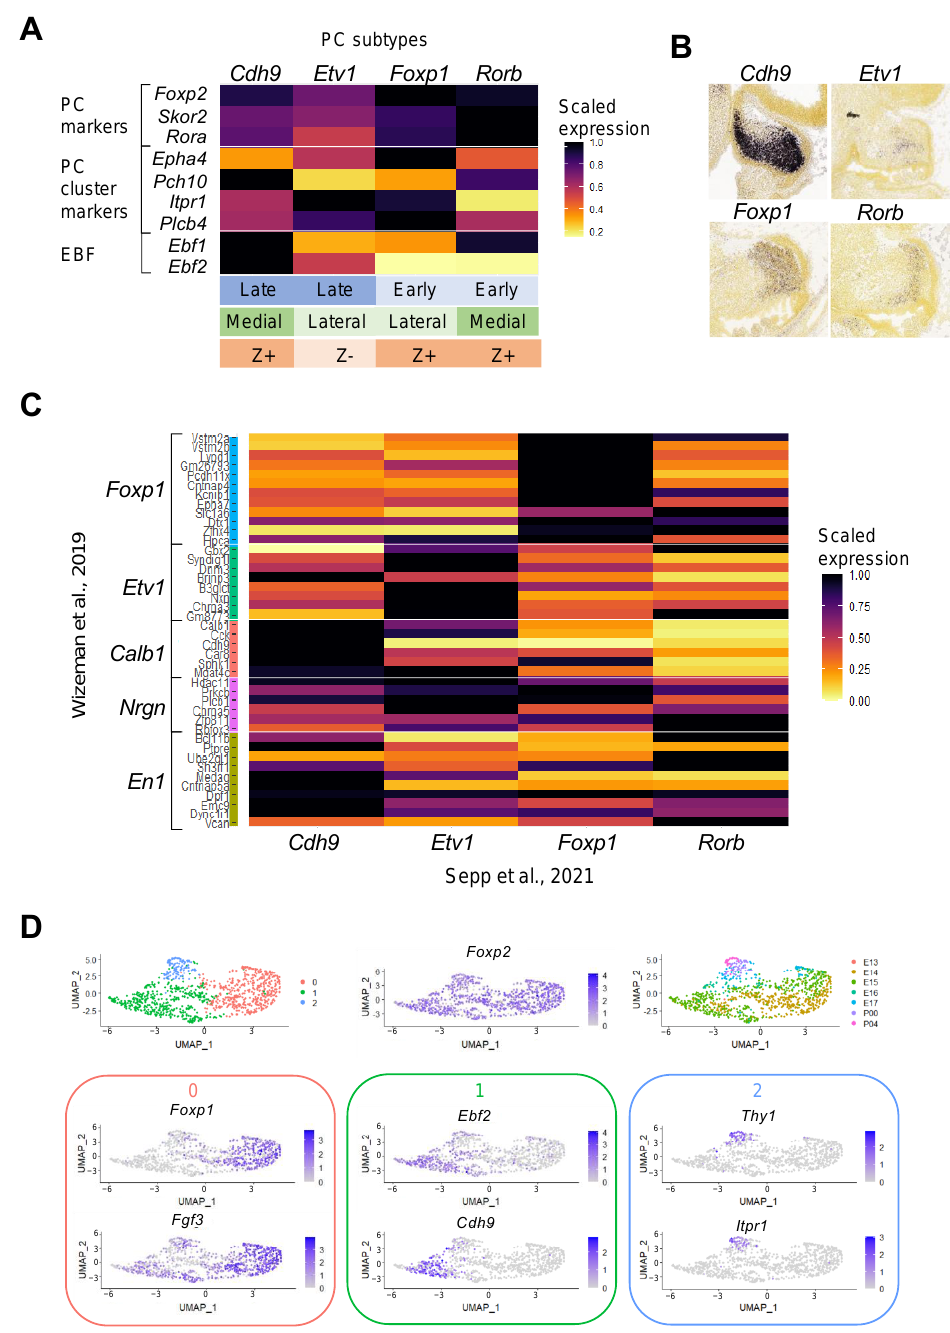
Figure 4. Mouse embryonic Purkinje cell clusters defined by single-cell transcriptomics. ( A ) Sepp et